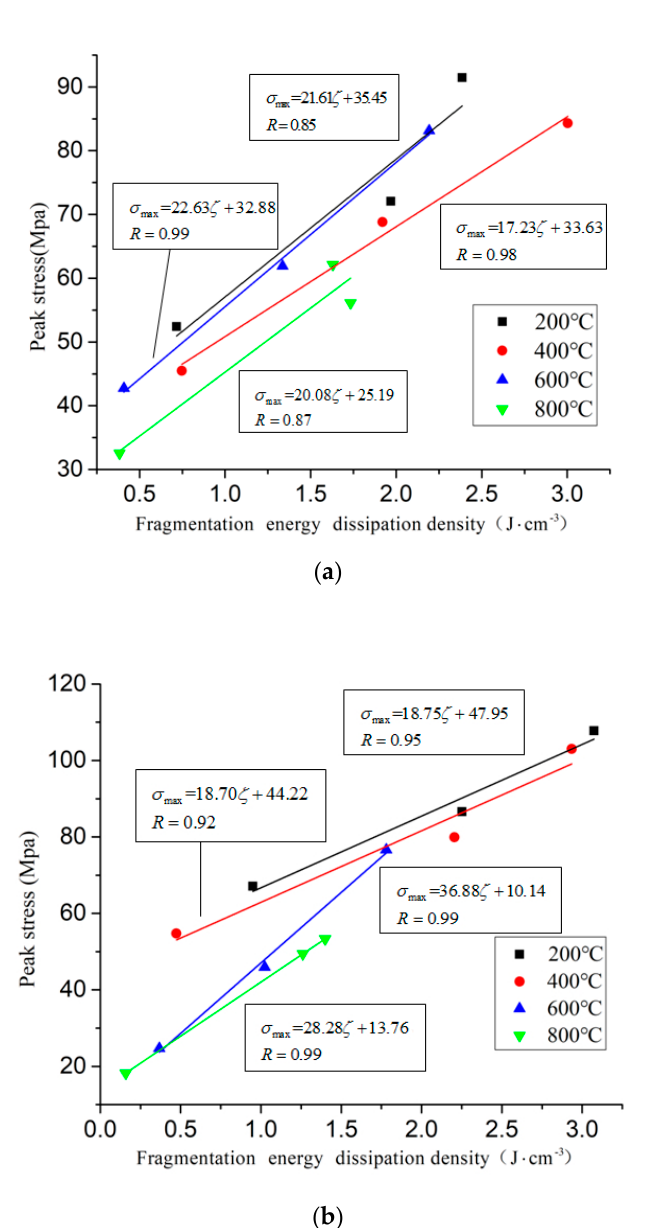
Figure 17. The linear relationship between fragmentation energy dissipation density and peak stress under different conditions. ( a ) Rapid heating and natural cooling ( b ) Slow heating and water cooling.